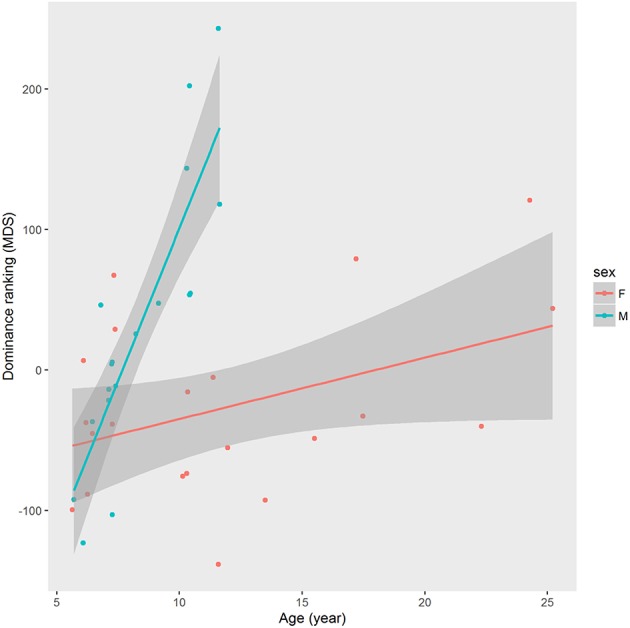
Linear regression between dominance rank (MDS) and age (years) in semi-free ranging group of mandrills (Mandrillus sphynx) stratified by sex. The line represents the curve estimated by the linear model and the gray shape represents the standard error. The scatter plot was realized with the ggplot2 package (Wickham, 2009).